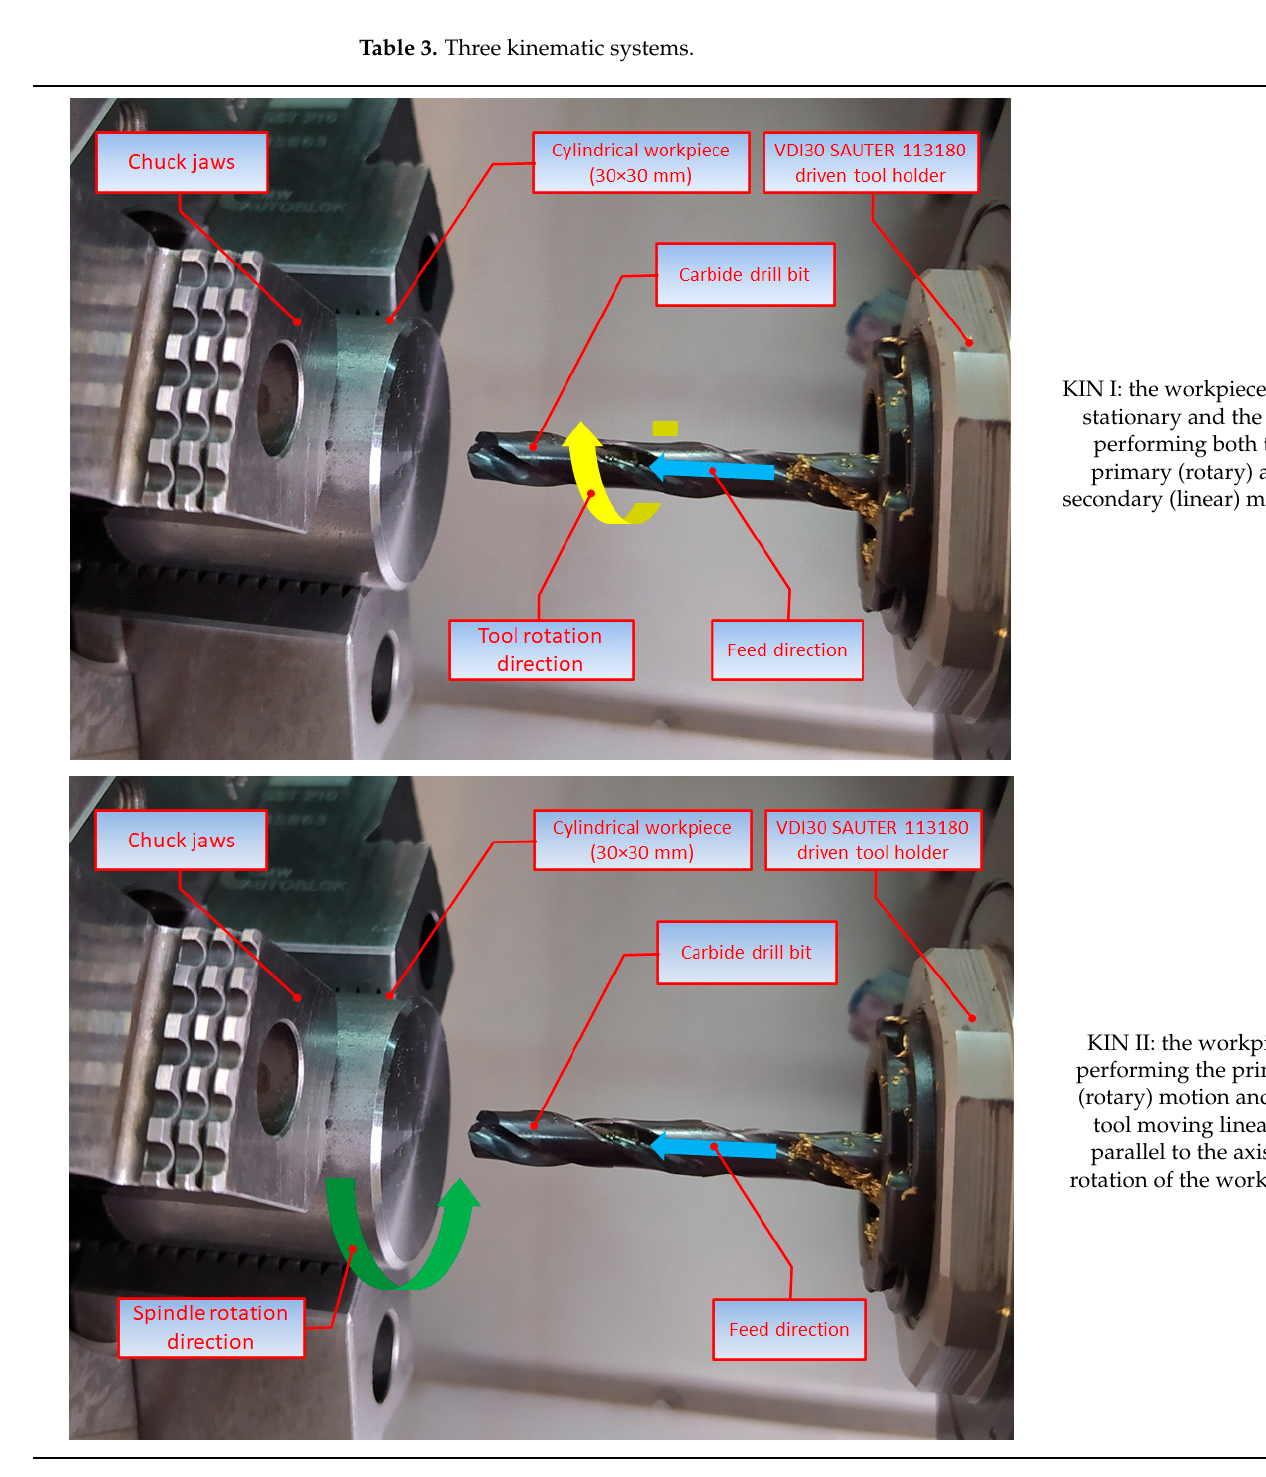
Figure 1. A SEM image of the material studied.